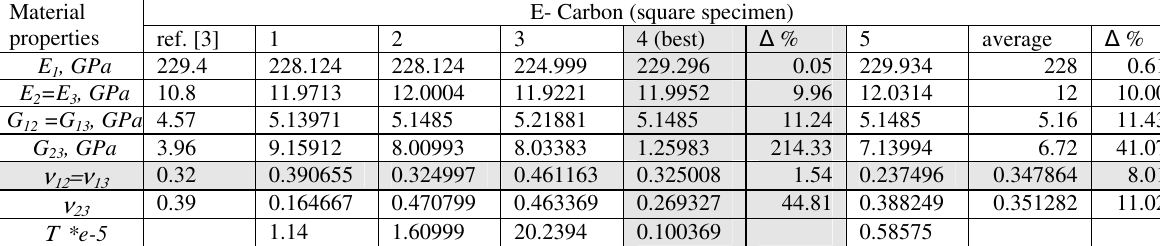
Table 6. Identified material properties of carbon-epoxy specimen (rectangular specimen)